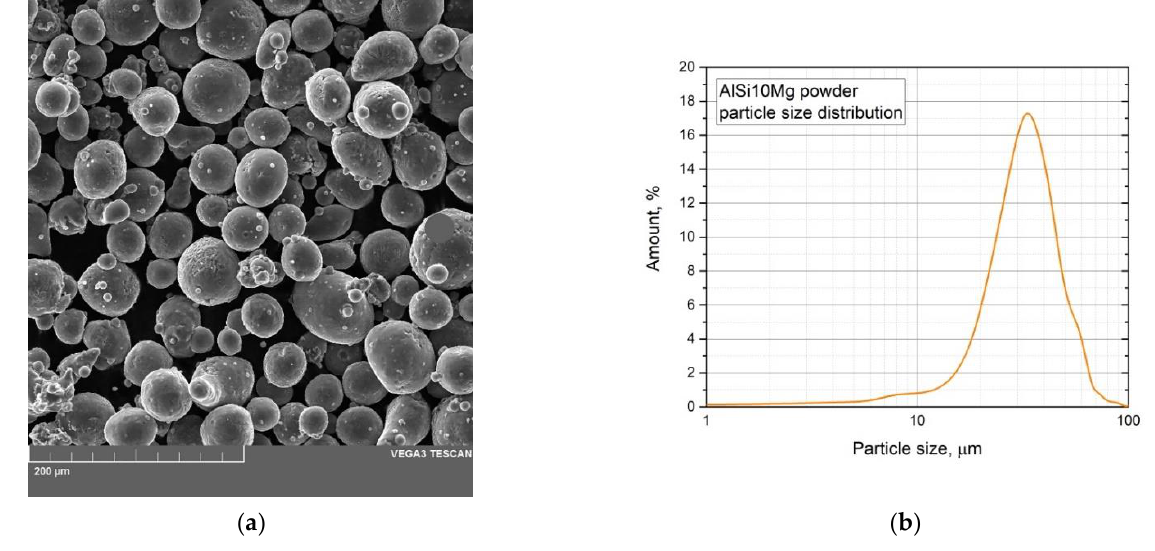
Figure 4. Morphology of AlSi10Mg matrix powder ( a ) and its particle size distribution ( b ). Analysis of obtained samples showed relative density (RD) varied from 97.1 to